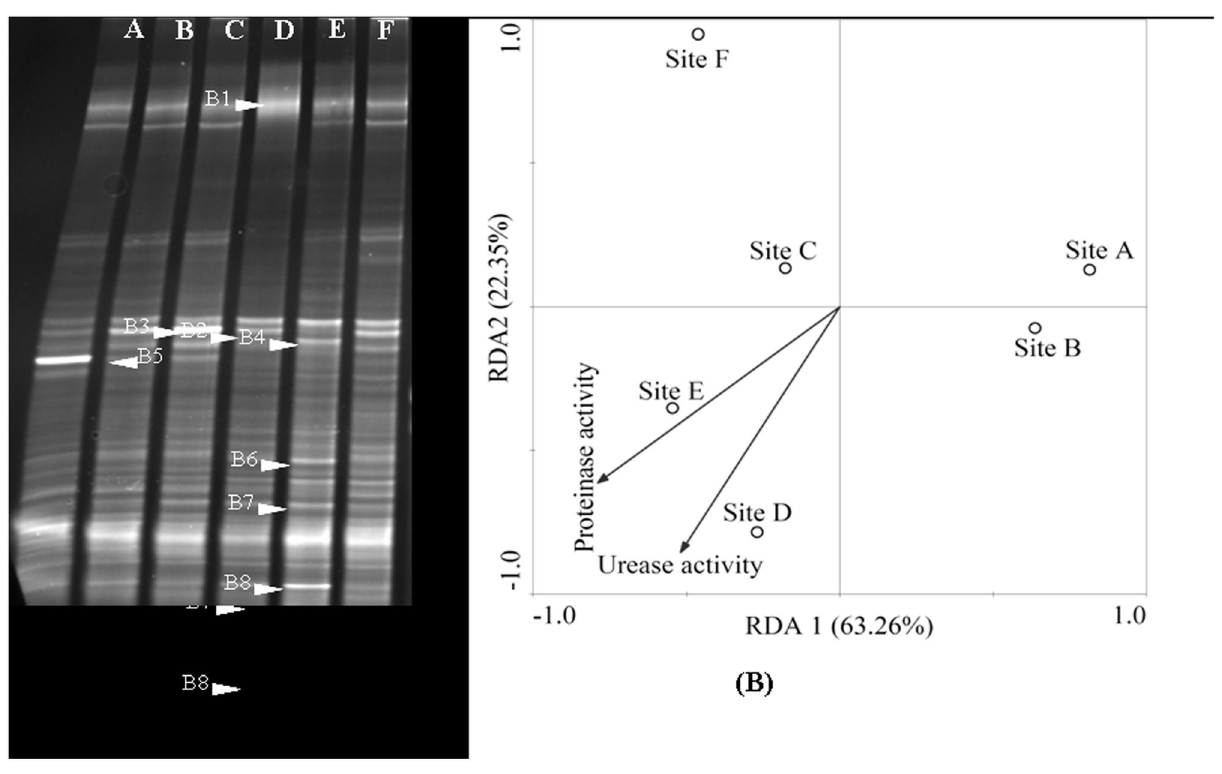
Figure 4. DGGE profiles of PCR-amplified 16S rRNA gene (V3 region). (A) Fragments in a denaturing from 30% to 70% gradient gel. B1-B8 represents sequenced bands in the bacterial community DGGE gel. (B) Redundancy Analysis (RDA) of bacterial community in the sediments from each six sampling sites (site A, site B, site C, site D, site E, site F) in the Zhou cun drinking water reservoir, eastern China. Samples are represented by open circles and the capital letters refer to the sampling sites. Numbers in brackets represent the percentage of variation explained by each factor, RDA1 explains 63.26% of the variance of the data and RDA2 explains 22.35% of the variance in the data, respectively. Significant factors for variation extracted from environmental data (sediment urease and protease activity) are given as